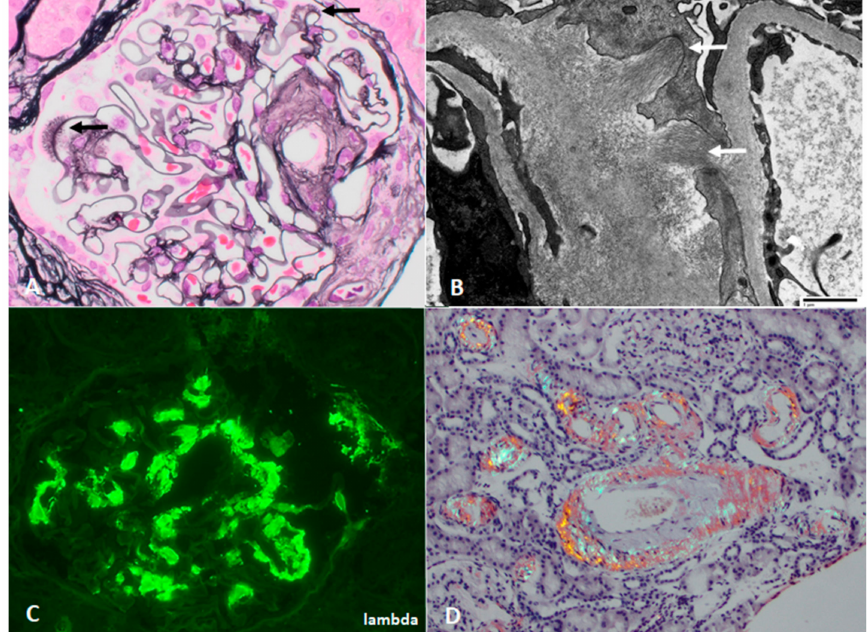
Figure 3. Kidney biopsy images of AL amyloidosis, with ( A ) “spicules” on Jones stain (arrows, 600 × ) and ( B ) haphazardly arranged fibrils infiltrating capillary loops with associated podocyte foot process effacement (arrows, transmission EM direct mag 6800 × ), corresponding with the common nephrotic presentation. Deposits show ( C ) smudgy glomerular staining for lambda light chain, and ( D ) prominent vascular involvement is also present (Congo red stain under polarized light, 200 ×